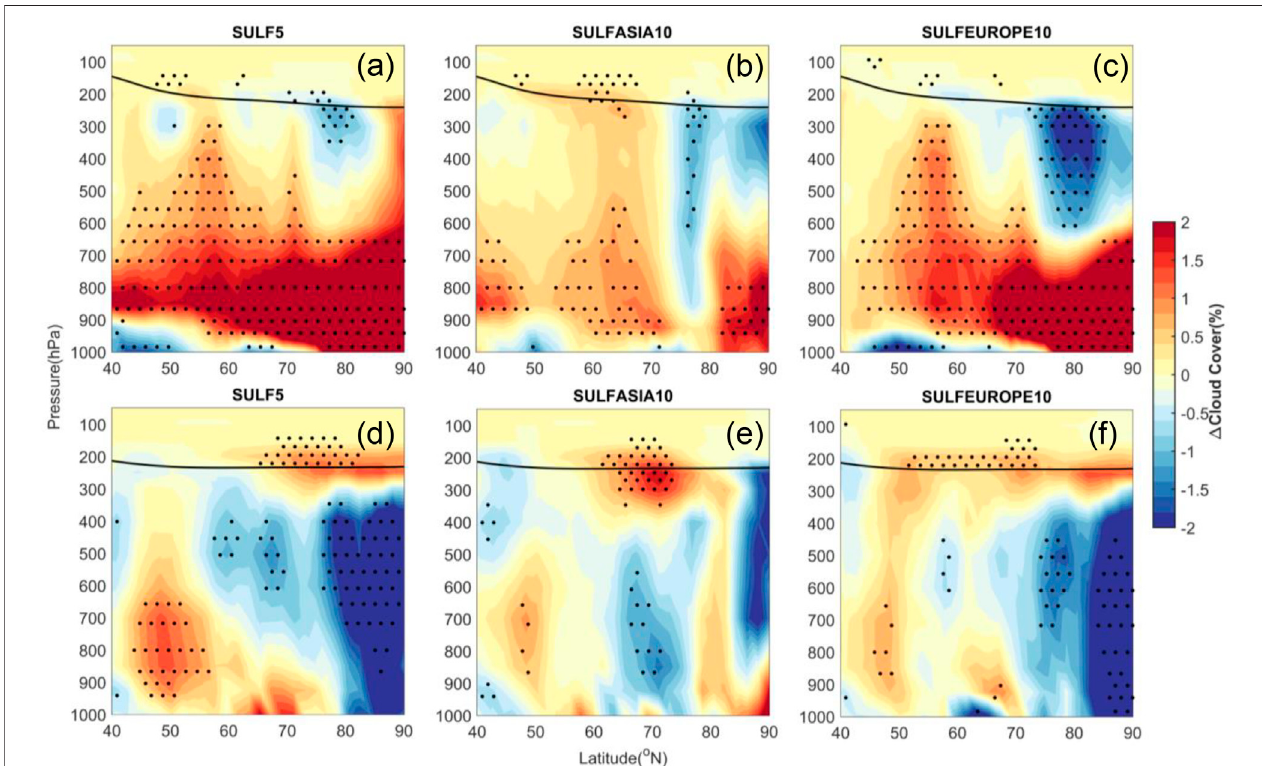
FIGURE5| Zonalmeanlatitude-heightplotofcloudfractionforsummer (A – C) andwinter (D – F) forSULF5,SULFASIA10,SULFEUROPE10experiments.Stippling indicates statistical signi fi cance at 90% con fi dence level determined using student ’ s t-test for the difference of the mean. The black line indicates the climatological tropopause (CTRL) for corresponding